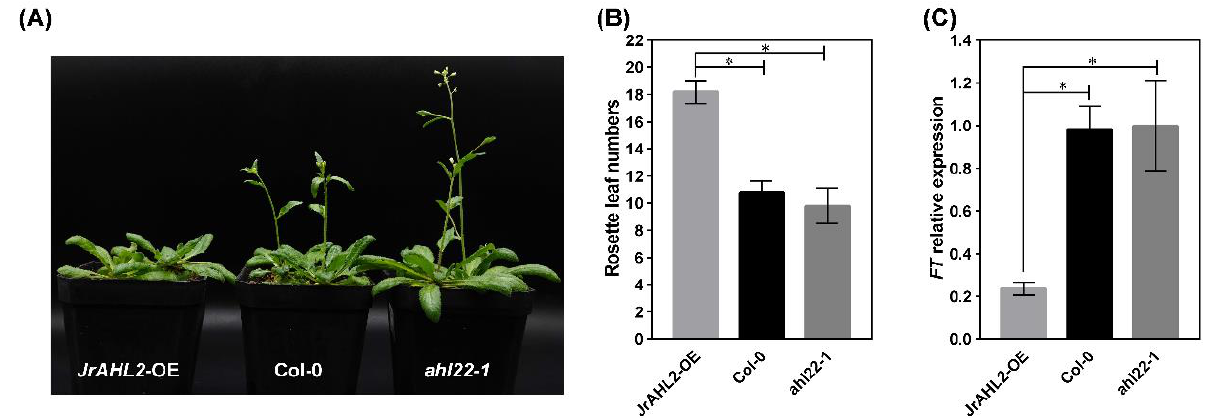
Figure 11. JrAHL2 affects flowering in Arabidopsis. ( A ) Flowering phenotype of JrAHL2 -overexpressing ( JrAHL2 -OE), wide type (Col-0), and AtAHL mutant ( ahl22-1 ) Arabidopsis lines, respectively. ( B ) The number of rosette leaves at flowering. ( C ) The expression level of flowering-related gene FT . The columns represent the mean values of three replicates ± standard deviations. The asterisk (*) indicate significant differences, as determined by Student’s t -test at the 0.05 level.